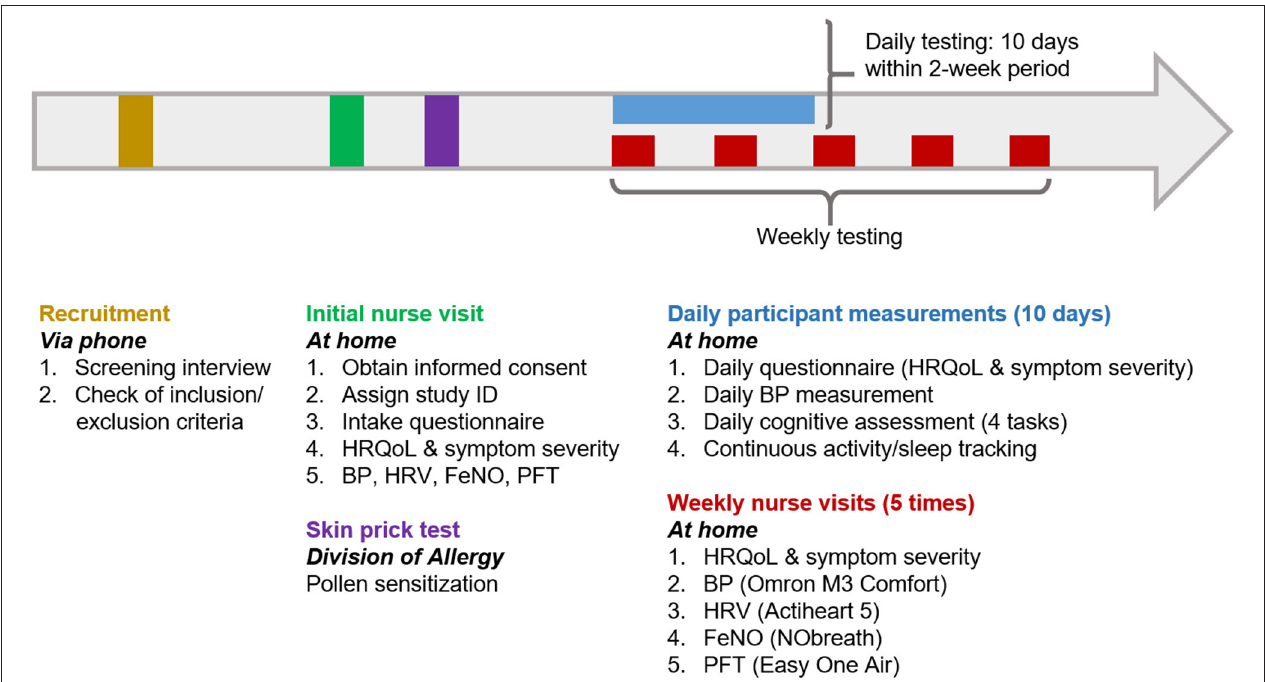
FIGURE 1 | Visual representation of a typical EPOCHAL study participation timeline. This timeline will be initiated in February 2021. The skin prick test can be scheduled at any time after the initial nurse visit. The 10 days of participant data collection may occur within an overall 14-day period (this will allow for cessation of data collection over weekends, if preferred). This scheduling will be determined based on the participant’s self-reported months of typical IAR symptoms (applicable to individuals with pollen sensitization) and acceptable months of enrollment (February through August) for all participants. HRQoL, Health-related quality of life; HRV, heart rate variability; BP, blood pressure; FeNO, fractional excretion of nitric oxide; PFT, pulmonary function